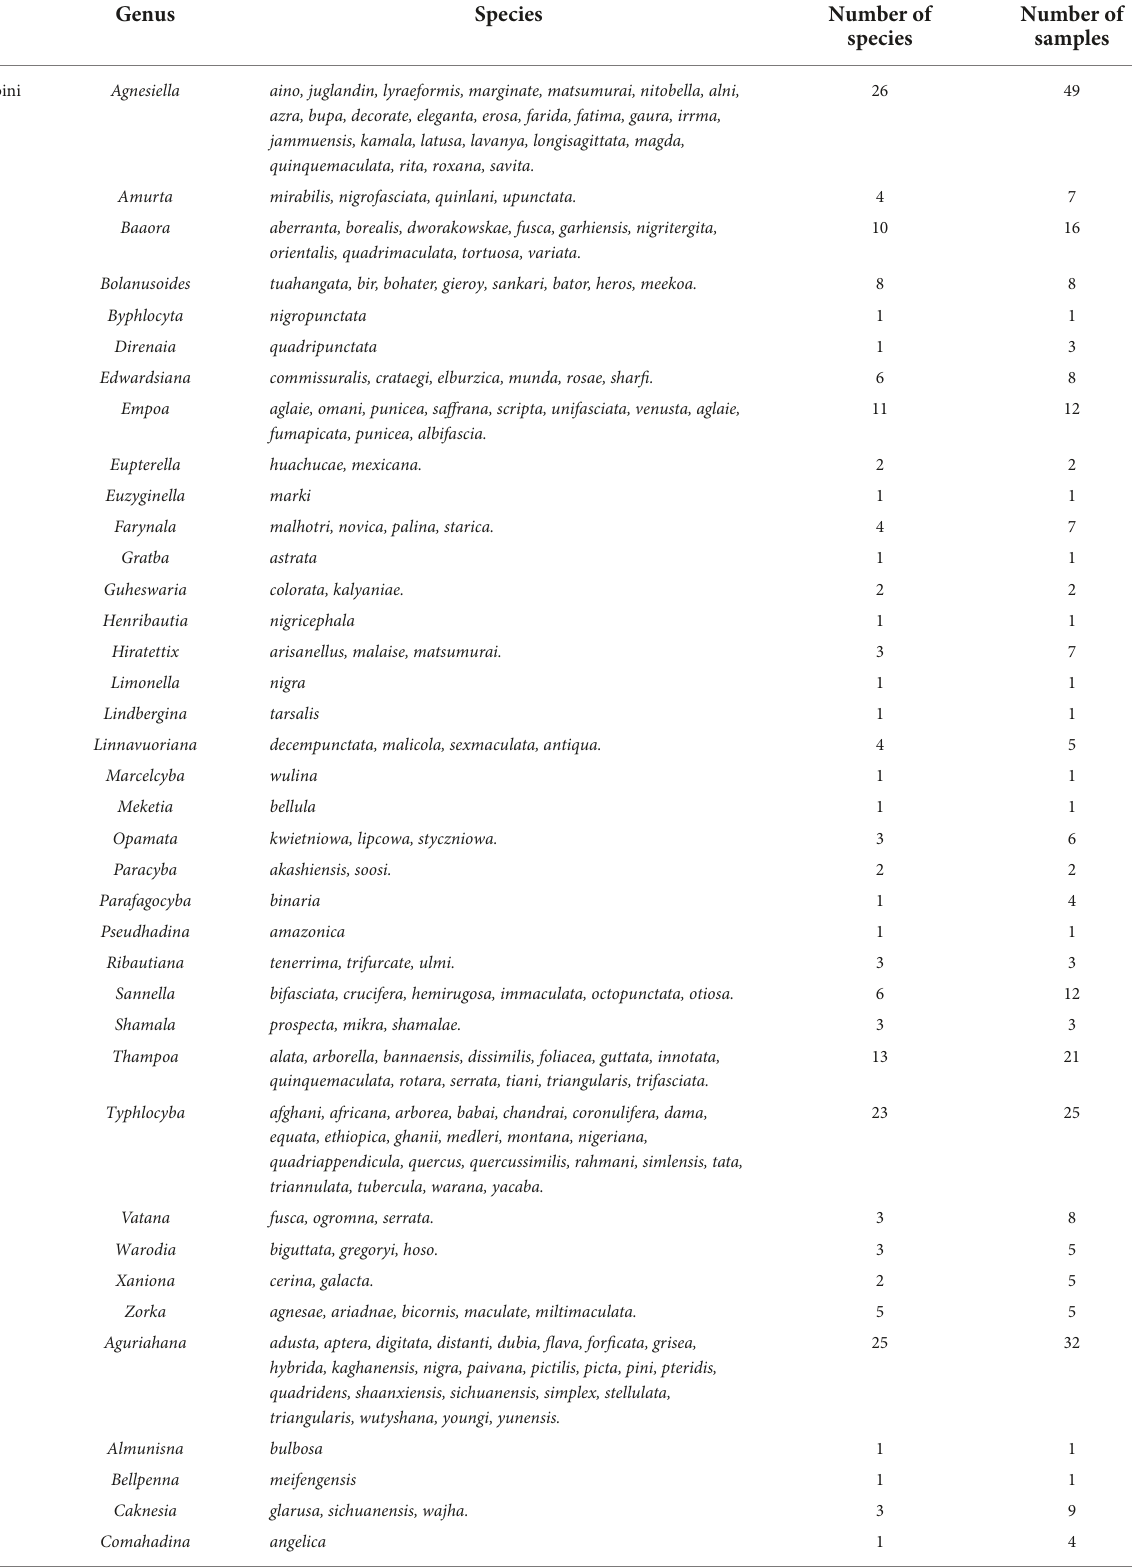
TABLE 1 Representative taxa selected in this study. Tribe